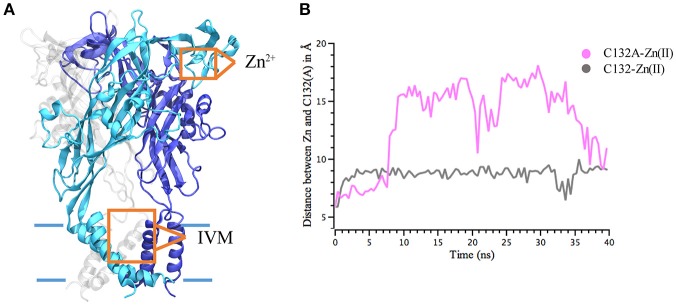
Interaction distance between Zn(II) and P2X4R calculated through molecular dynamics simulations. Calculated 40 ns MD simulations of Zn(II) interaction with the P2X4R holo. (A) Model of P2X4R showing the putative Zn(II) site in the extracellular domain and IVM binding site in the TM region. (B) Distance between Zn(II) and S atom of C132wt P2X4R (gray) or Cβ of the C132A mutated P2X4R (pink).